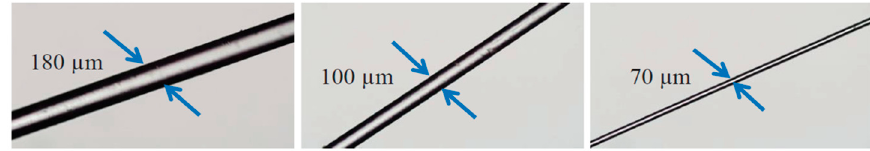
Figure 1. Microscopic images of polymer fibres before etching (180 µm) and after etching (100 µm and 70 µm).